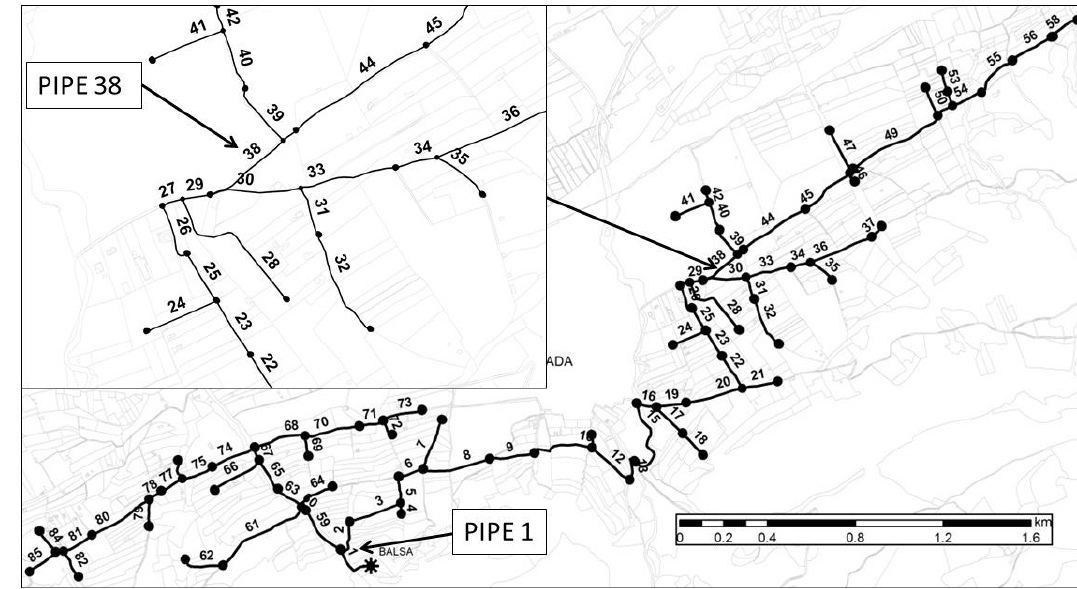
Figure 12. Identification of pipes in the irrigation network. Water 2016 , 8 , 234